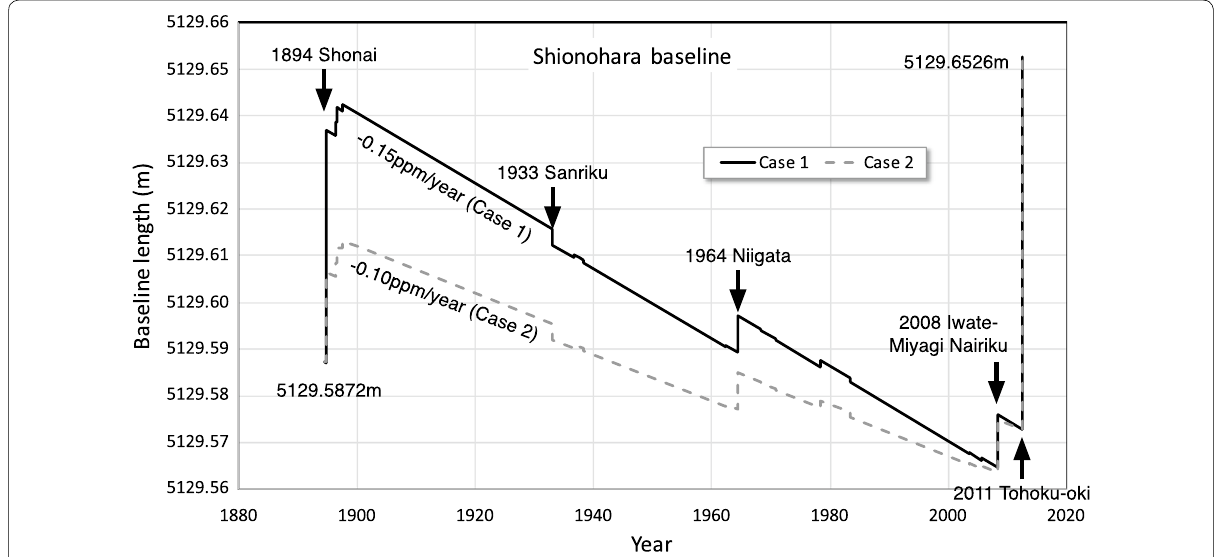
0 km, L 30 km, W 15 km, φ 0º, δ 30º, λ 90º, Δ u 1.5 or 3.0 m = = = = = = =